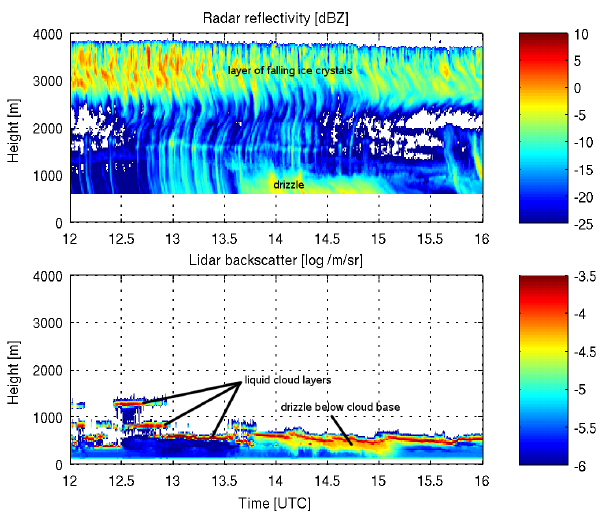
Fig. 4. Time series of vertically pointing cloud Radar and Lidar ceilometer measurements during the flight. Key features are anno- tated for